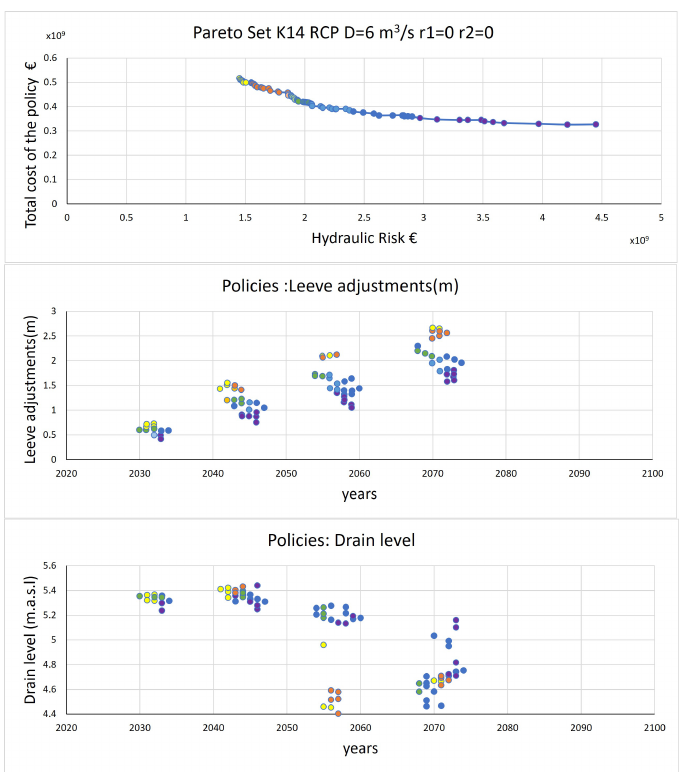
Figure 12. Size and timing of Flood defence constructions for the Pareto set optimal